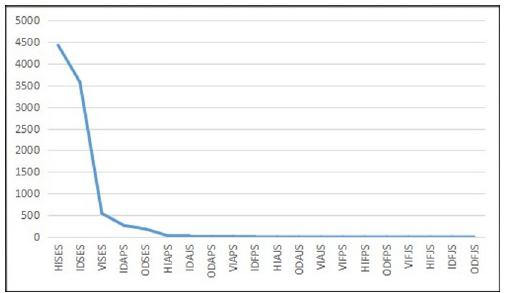
Fig 8. The distribution curve of class numbers for RSE in China from 2003–2014 (Unit: Quantity). HISES is Hearing Impairment for Special Education Schools. IDSES is Intellectual Disability for Special Education Schools. VISES is Visual Impairment for Special Education Schools. IDAPS is Intellectual Disability Classes Attached to Primary Schools. ODSES is Other Disability for Special Education Schools. HIAPS is Hearing Impairment Classes Attached to Primary Schools. IDAJS is Intellectual Disability Special Classes Attached to Junior High Schools. ODAPS is Other Disability Classes Attached to Primary Schools. VIAPS is Visual Impairment Classes Attached to Primary Schools. IDFPS is Intellectual Disability Followers in Primary Schools. HIAJS is Hearing Impairment Special Classes Attached to Junior High Schools. ODAJS is Other Disability Special Classes Attached to Junior High Schools. VIAJS is Visual Impairment Special Classes Attached to Junior High Schools. VIFPS is Visual Impairment Followers in Primary Schools. HIFPS is Hearing Impairment Followers in Primary Schools. ODFPS is Other Disability Followers in Primary Schools. VIFJS is Visual Impairment Followers in Junior High Schools. HIFJS is Hearing Impairment Followers in Junior High Schools. IDFJS is Intellectual Disability Followers in Junior High Schools. ODFJS is Other Disability Followers in Junior High